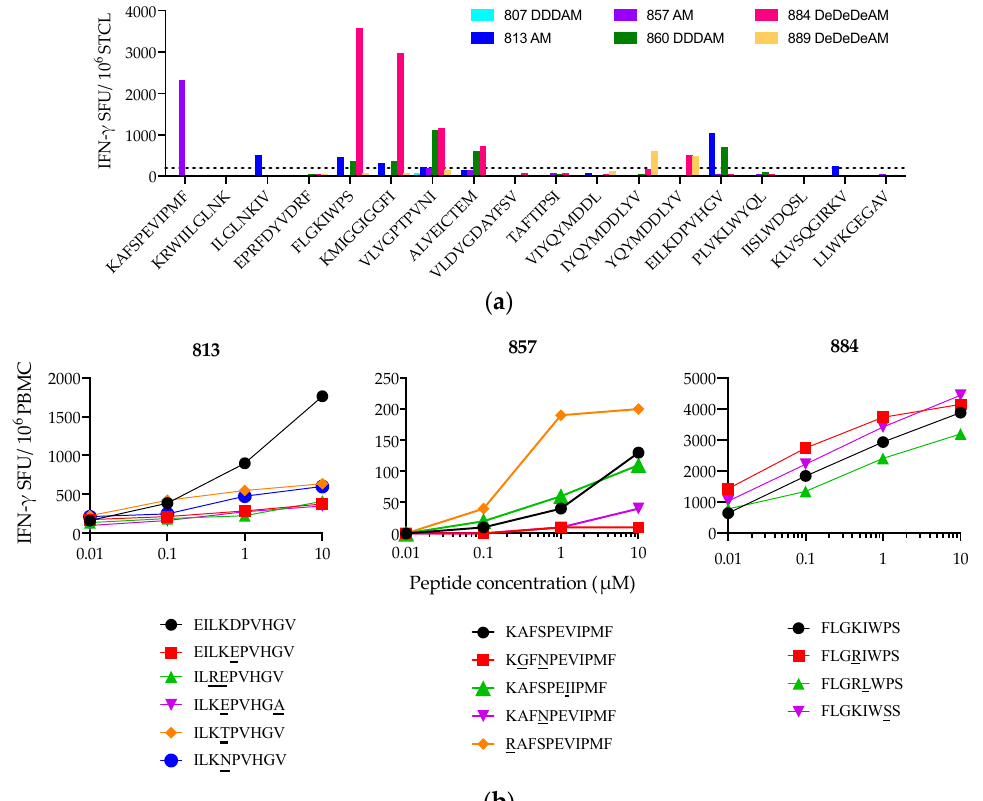
Figure 5. Heterogeneity in HLA-A*02:01-restricted T-cell responses. ( a ) HLA-A*02:01-positive vaccine recipients were tested for recognition of reportedly HLA-A*02:01-restricted epitopes present in HIVconsv. Their PBMC were expanded with a pool of corresponding parental 15-mers peptides containing the tested epitopes and assessed in an IFN- γ ELISPOT assay. Dotted line indicates the background frequency corresponding to 5 SFU per well. ( b ) Titration of epitope variants tested for induction of IFN- γ production by STCL.